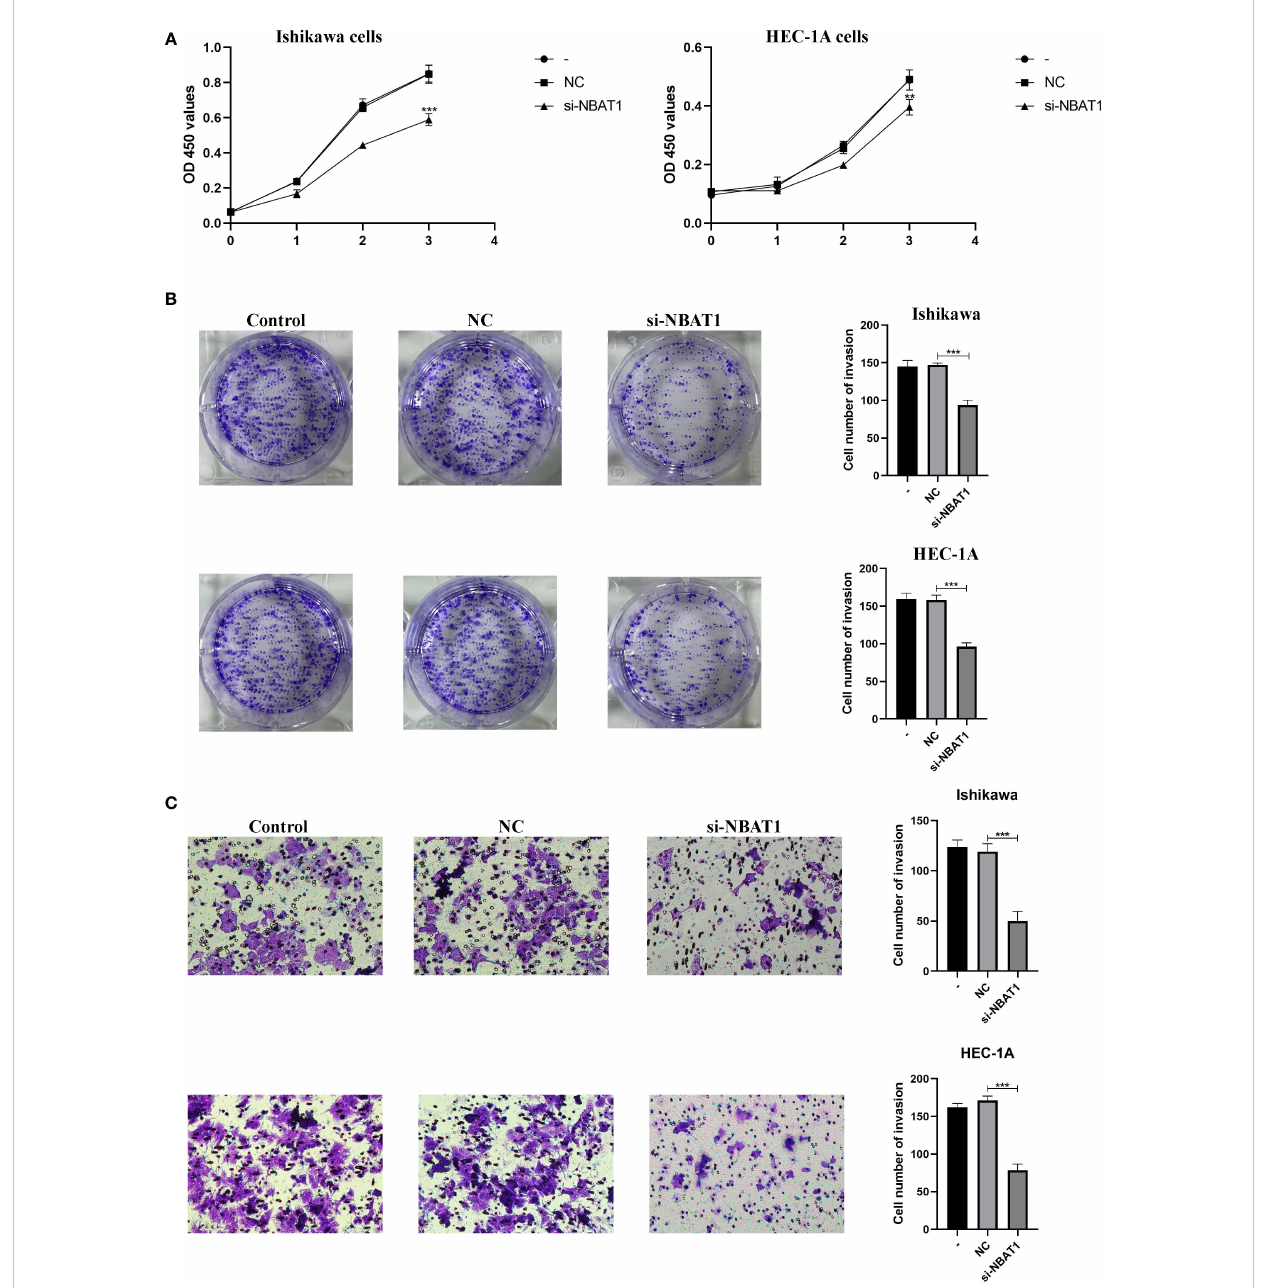
FIGURE 8 NBAT1 regulates the biological behavior of Ishikawa cell line and HEC-1A cell line. (A, B) CCK-8 and colony formation assays were used to assess the proliferative effect of NBAT1 (C) Effect of NBAT1 on invasion assessed using the Transwell assay. (**P<0.01,